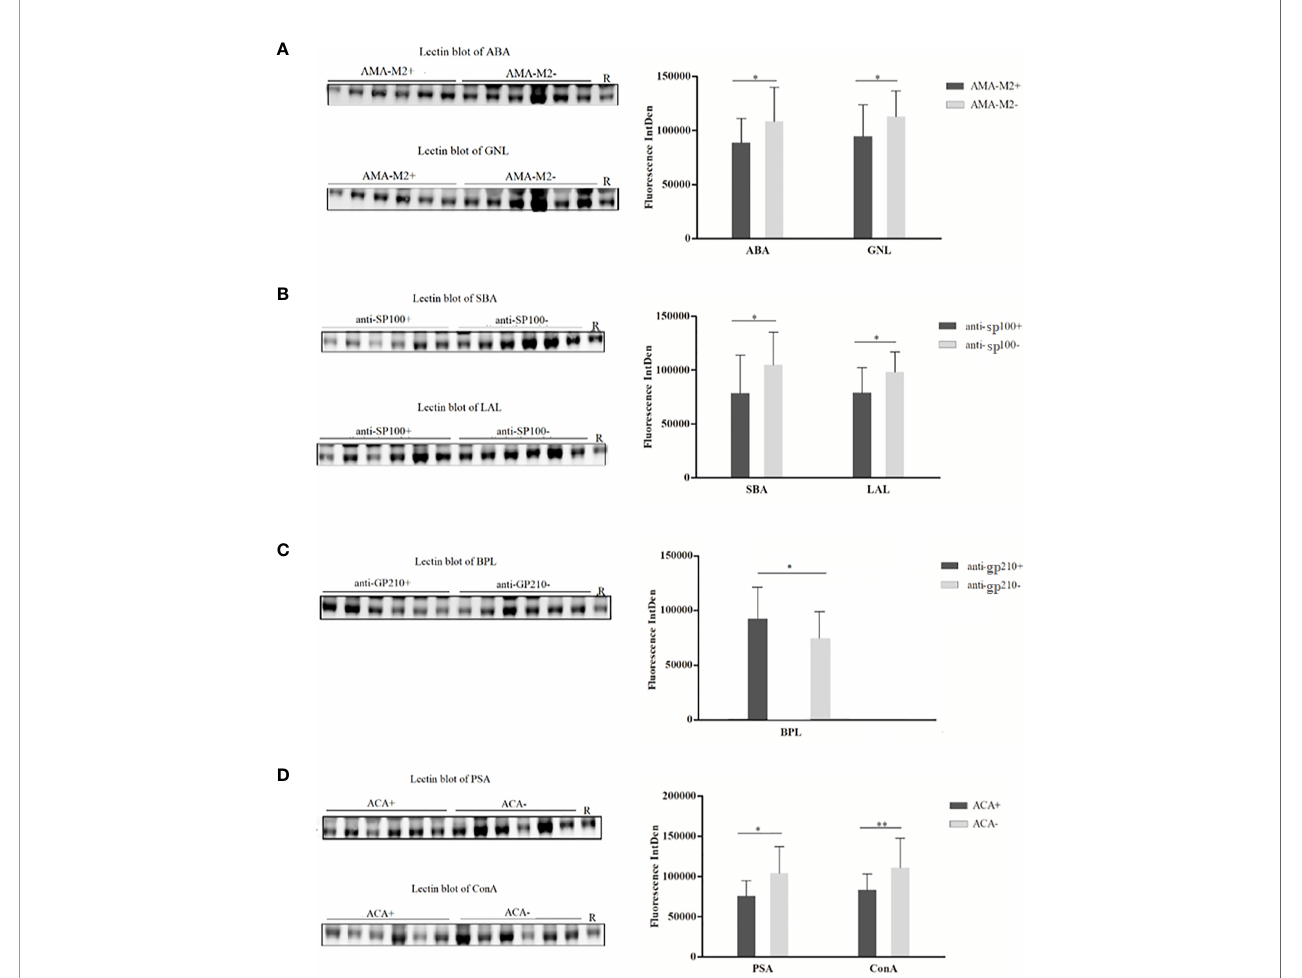
FIGURE 4 | Lectin blot of selected lectins for serum IgG between PBC subgroups. (A) Lectin blots for ABA and GNL and band fl uorescence intensity between AMA-M2 positive and negative groups. (B) Lectin blots for SBA and LAL, and band fl uorescence intensity between anti-sp100 positive and negative groups. (C) Lectin blots for BPL and band fl uorescence intensity between anti-gp210 positive and negative groups. (D) Lectin blots for PSA and ConA and band fl uorescence intensity between ACA positive and negative groups. * P < 0.05, **P < 0.05. ABA, Agaricus bisporus lectin; GNL, Galanthus nivalis lectin; SBA, glycine max lectin; LAL, Laburnum anagyroides lectin; BPL, Bauhinia purpurea lectin; PSA, Pisum sativum agglutinin; ConA, concanavalin A lectin; R, reference.